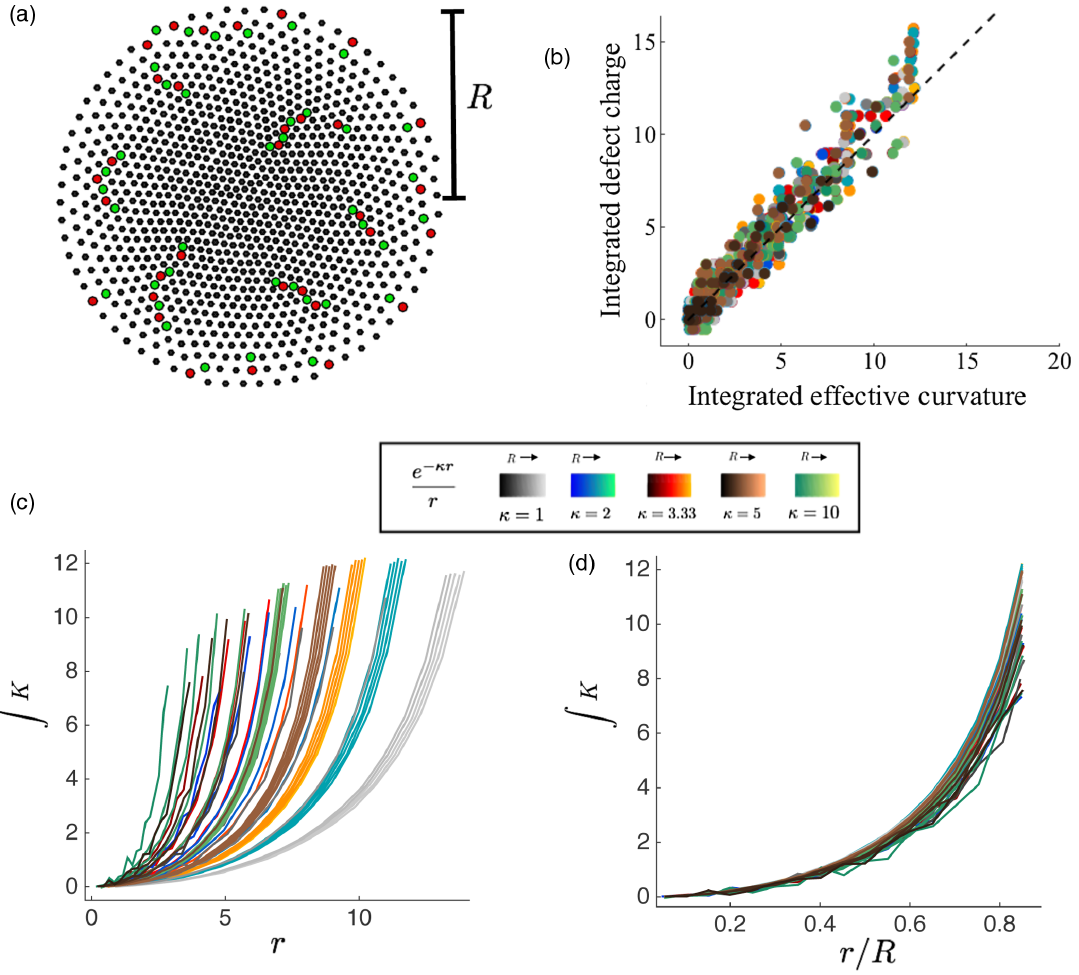
γ r 2 . (a) Example particle configuration. (b) Integrated FIG. 12. Yukawa interacting particles in a parabolic confining potential V ext ¼ effective curvature predicts final defect distribution as in the case for pure power-law potentials. (c) – (d) Scaling behavior of the integrated curvature profiles. With the additional length scale introduced by the screening length, our data suggest that the integrated curvature profiles no longer collapse when scaling the coordinates by the system